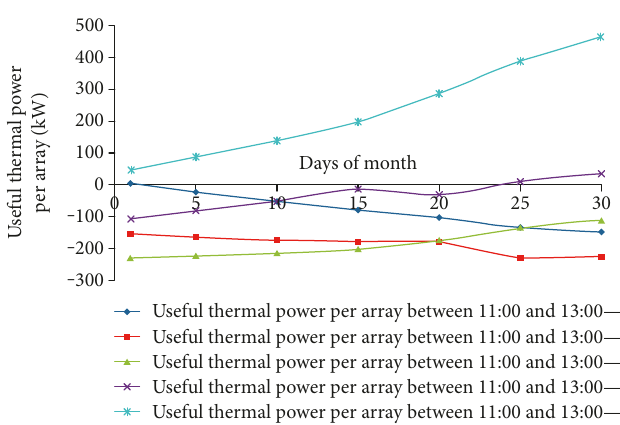
Figure 3: Useful thermal power per array for cold months.